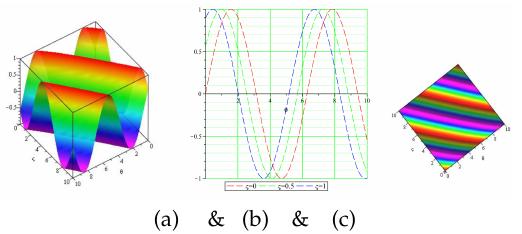
Fig. 4. 3D (left), 2D (middle) and contour (right) surfaces of imaginary part Eq. (36) when µ =